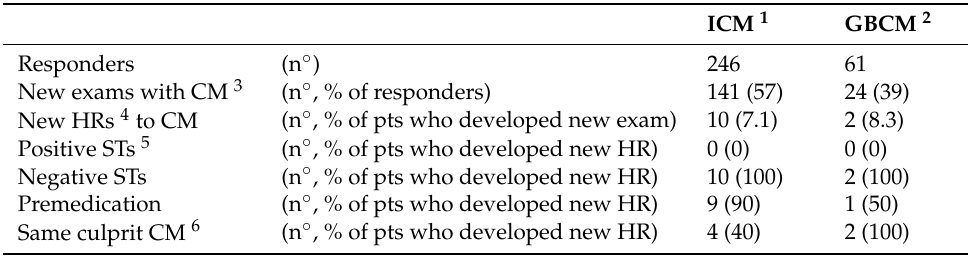
Table 5. Follow-up: results from phone